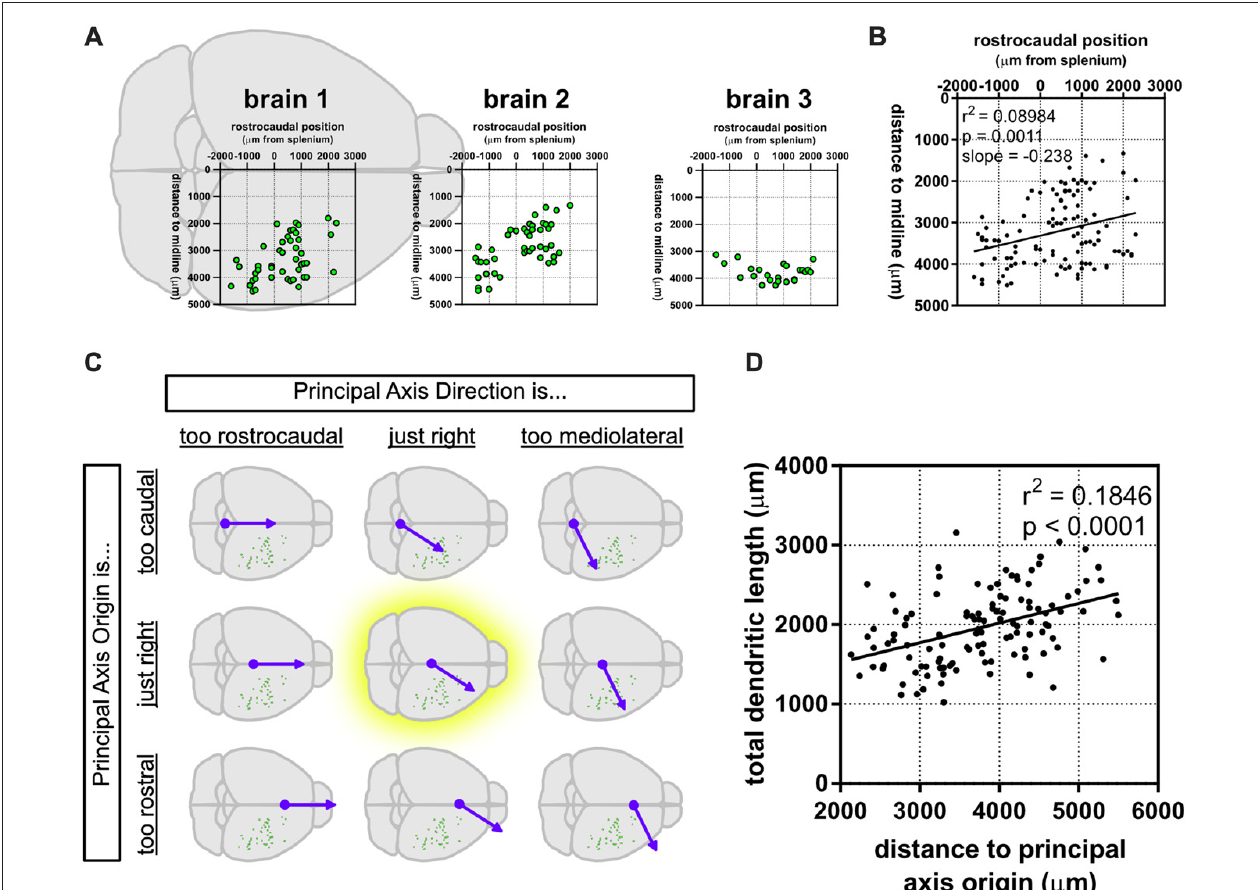
All comparisons >